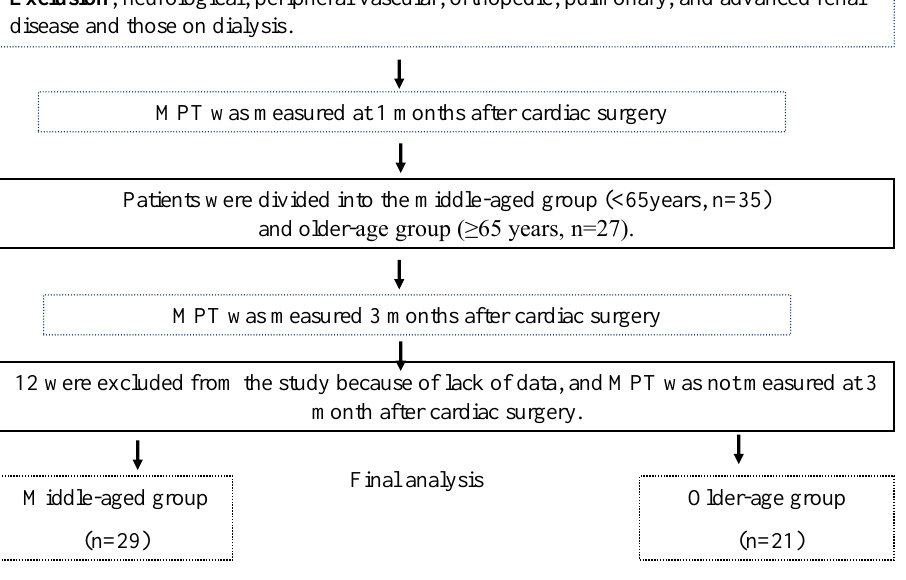
MPT was measured at 1 months after cardiac surgery